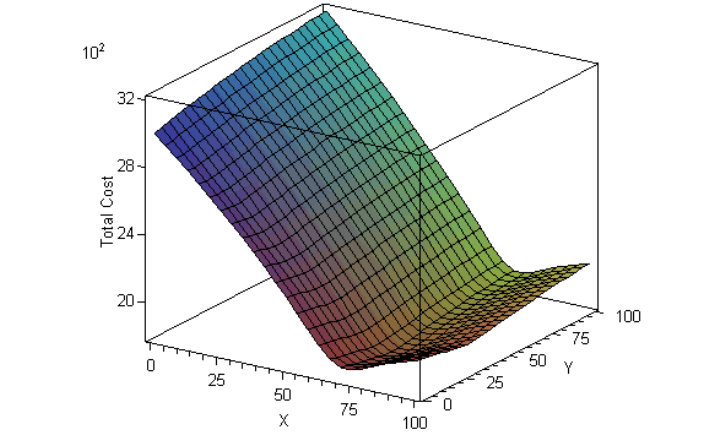
Figure 1. “Total cost depending on the manufacturing and remanufacturing capacities for V = 98.945”. Source: Own